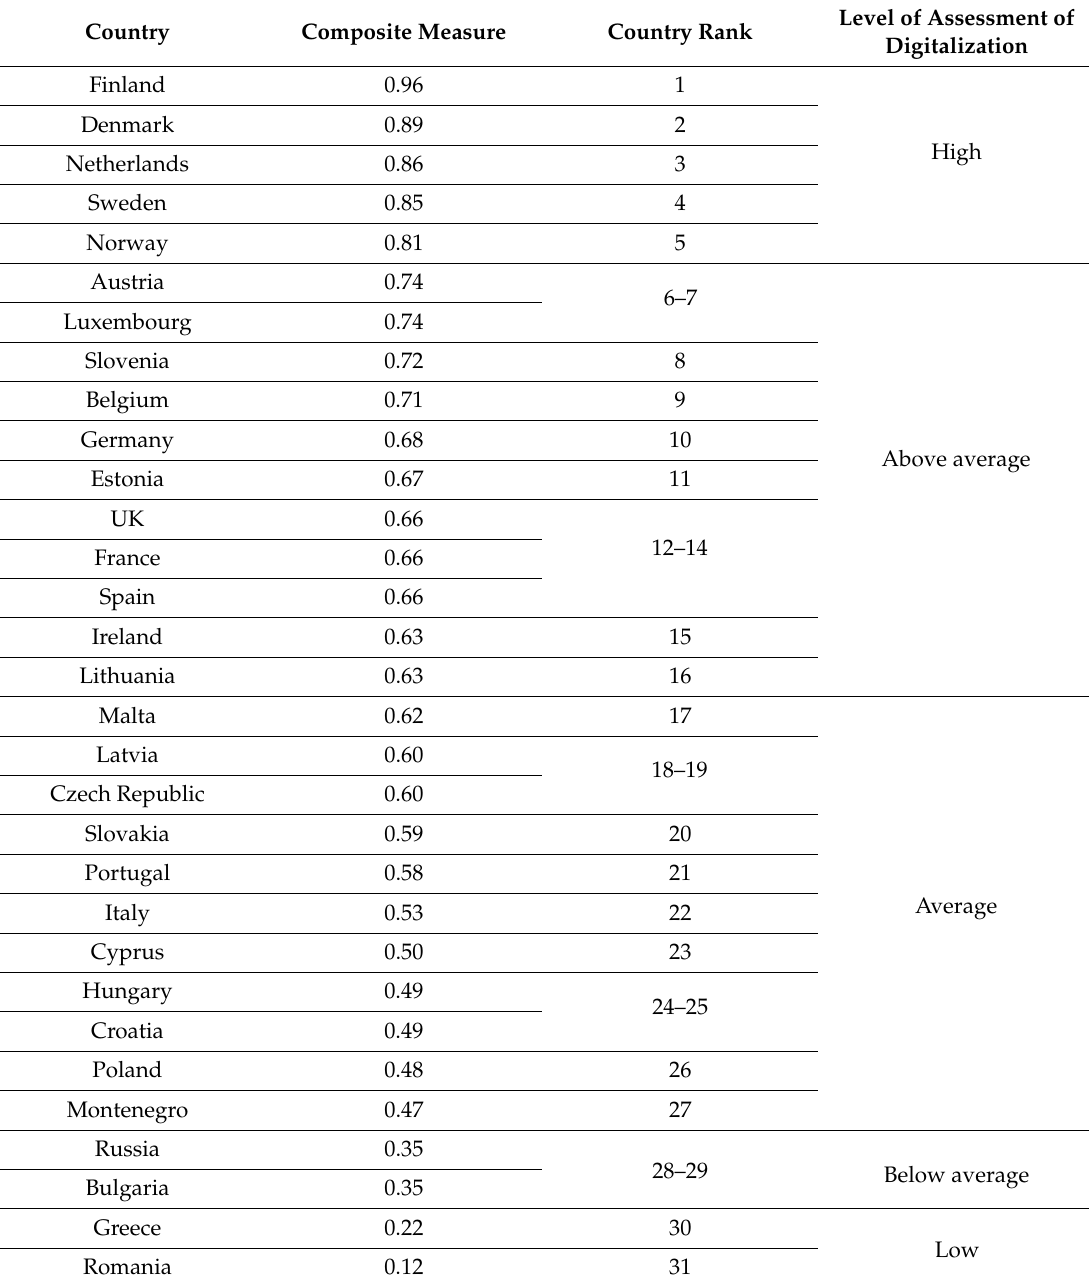
Level of Assessment